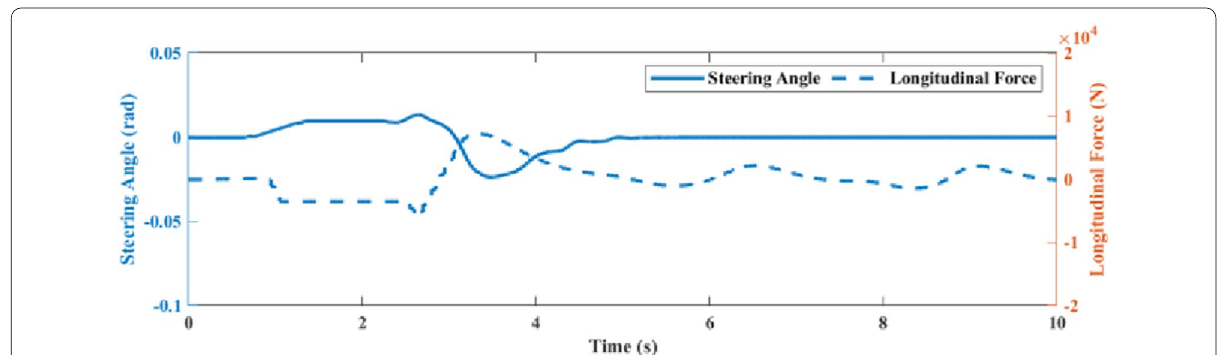
Figure 10 Steering angle and longitudinal force of ego vehicle with UAMP-RR method in case 1